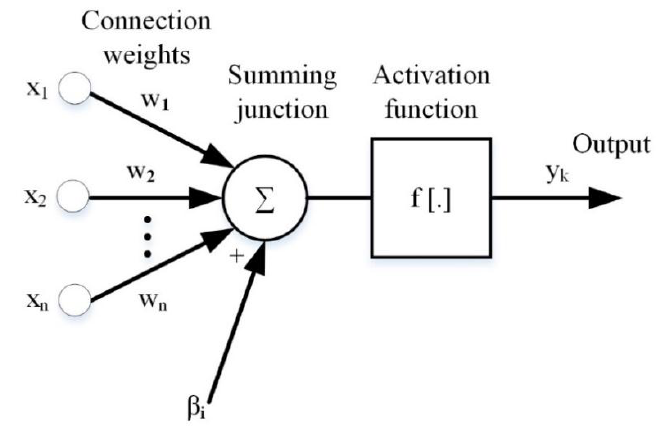
Figure 1. Neuron Figure 1. Neuron model.